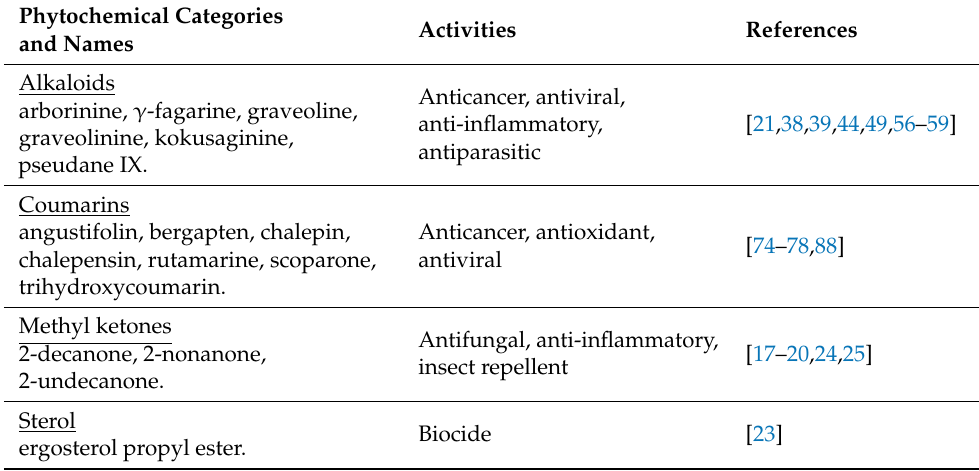
Table 1. Chemical components of R. angustifolia and their main pharmacological